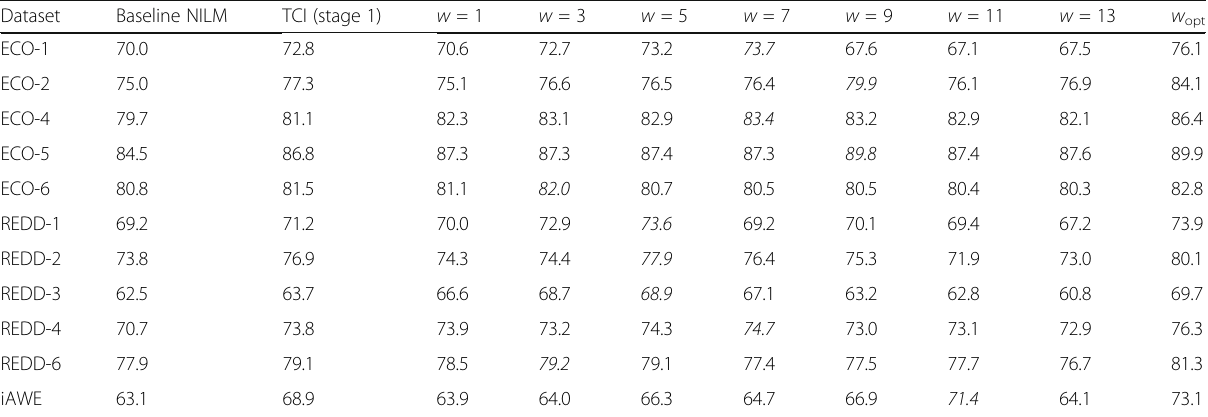
Table 5 Energy disaggregation performance in terms of estimation accuracy for the two-stage NILM methodology Dataset